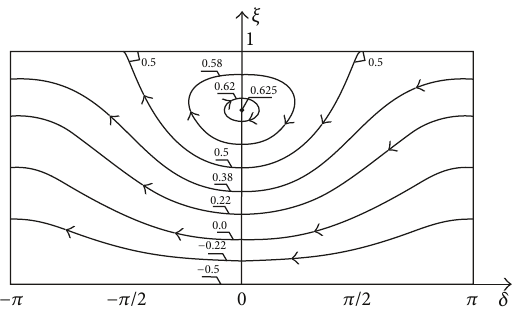
Figure 8: Phase portrait for the case of 1:1 internal resonance 𝜔 1 = 𝐾 (𝑏𝐸 ) −1 = −1 and 𝐾 𝜔 3 at 2 0